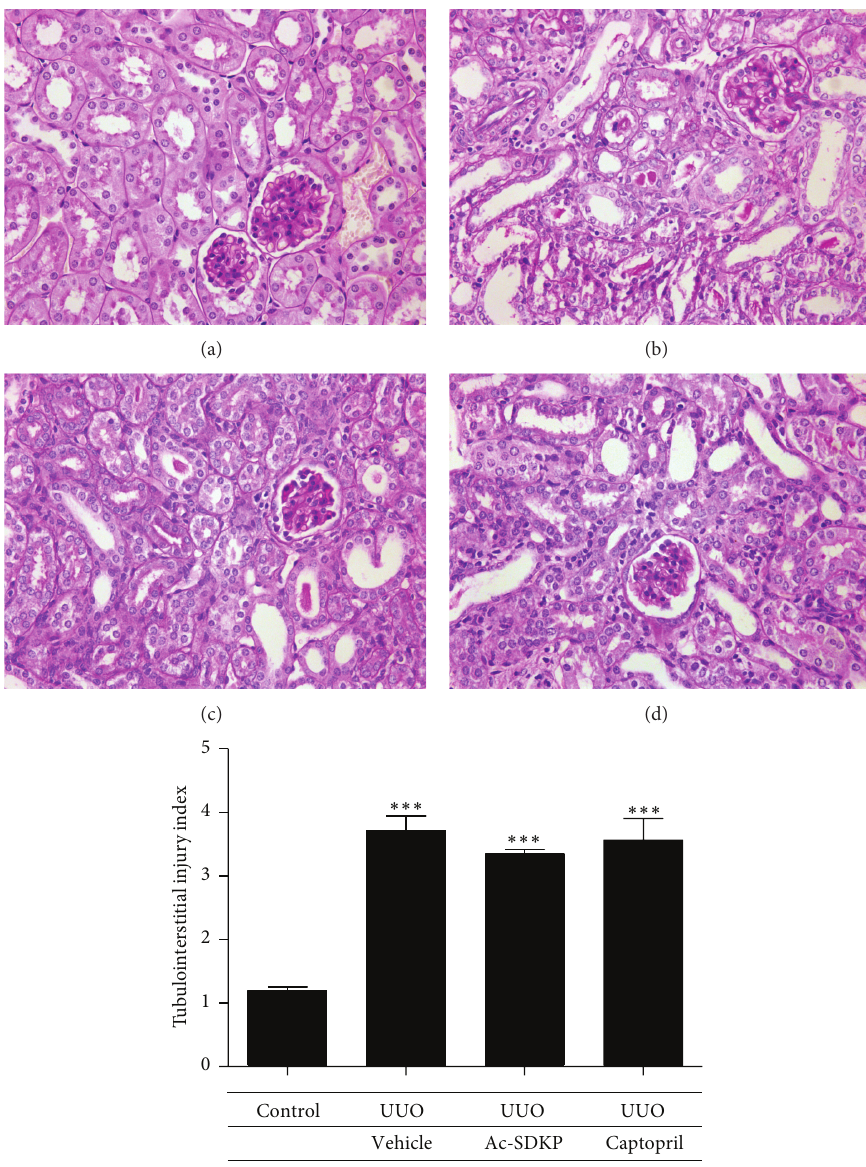
Figure 2: Histological changes. (a–d) PAS staining at day 7 of control animals (a), UUO operated animals (b), UUO animals with Ac-SDKP treatment (c), and UUO animals with Captopril treatment (d). Magnification (400x). (e) Tubulointerstitial injury index of renal cortex for assessing tubular and interstitial damage and graded in an observer-blinded manner from an arbitrary scale of 0–5 (1 ≤ 10%; 2 = 10–25%; 3 = 26–50%; 4 = 51–75%; 5 = 76–95%; 6 ≥